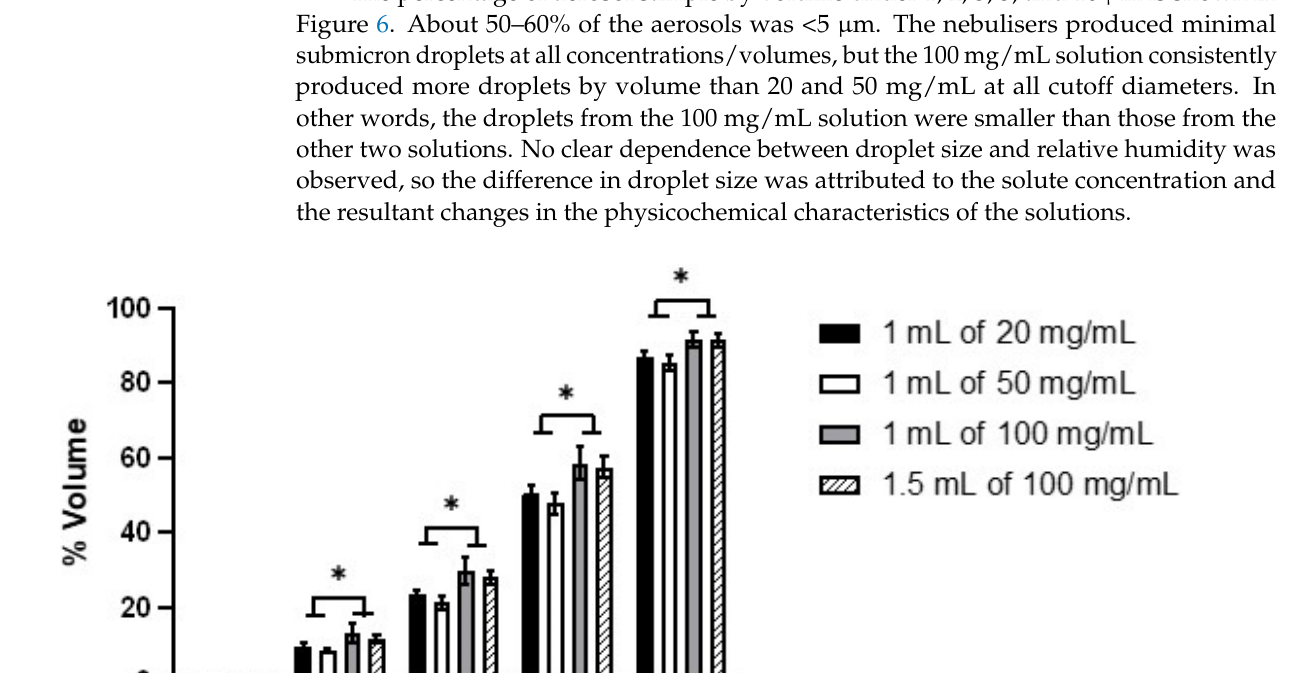
Figure 5. The geometric standard deviation of the droplets measured by laser diffraction. Data presented as mean ± standard deviation ( n = 9). Statistical difference indicated by * ( p < 0.05).